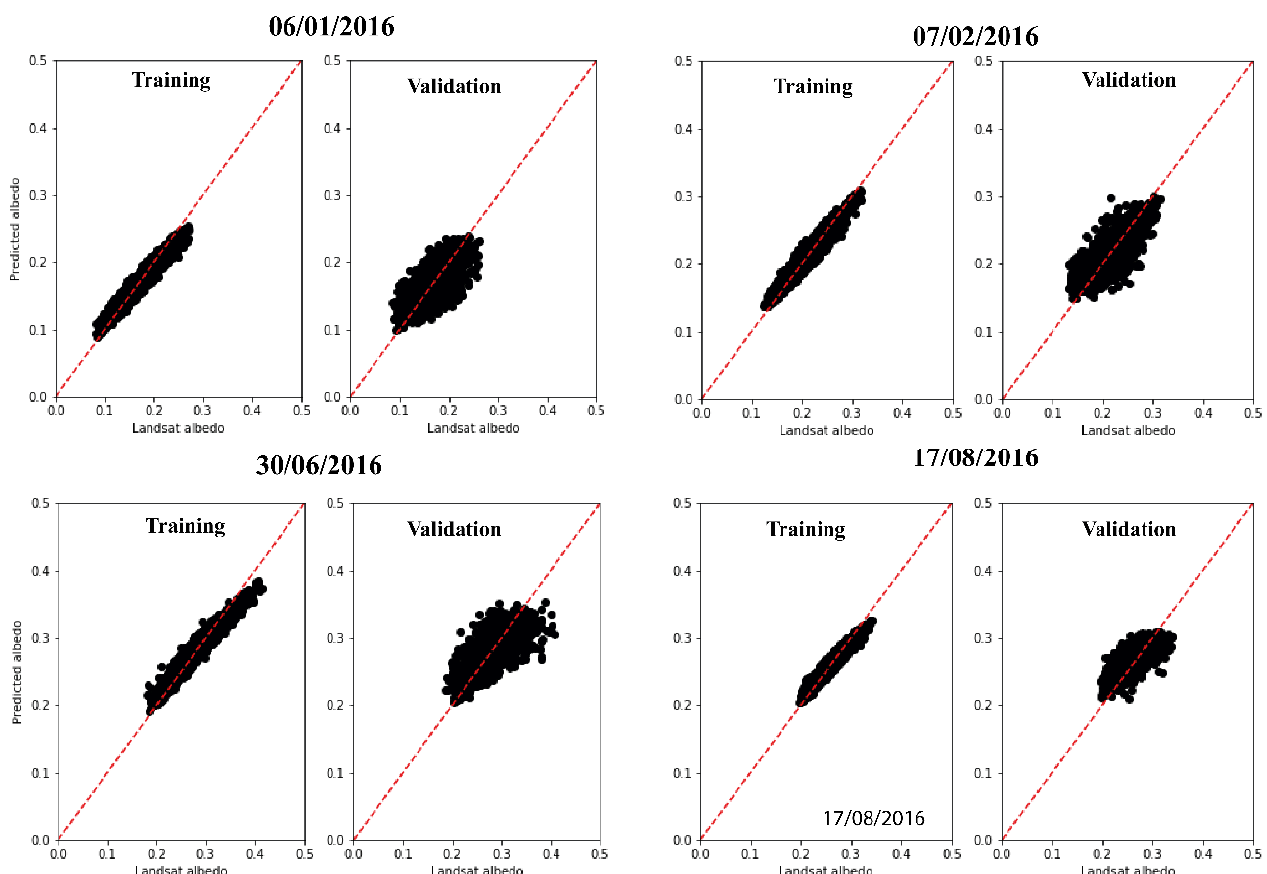
Figure 6. Comparison between predicted and Landsat estimates’ surface albedo for training and validation dataset. Using the 100 m Landsat albedo images as a reference, the retrieval results are visually and quantitatively analyzed in Figures 6 and 7. Results statistics are also reported Table 1. Summary statistics of the prediction algorithms.